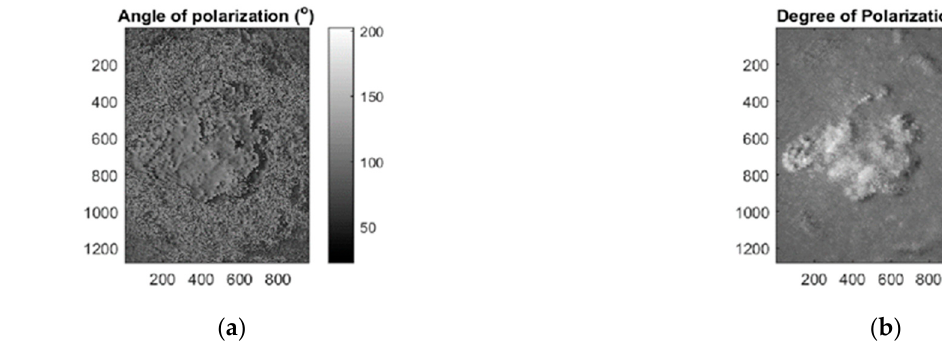
Figure 8. ( a ) Map of the measured AOLP (angle of linear polarization) from a melanoma lesion. ( b ) Map of DOP (degree of polarization) from the melanoma lesion. Notice the lesion region with a higher DOP than its surroundings.